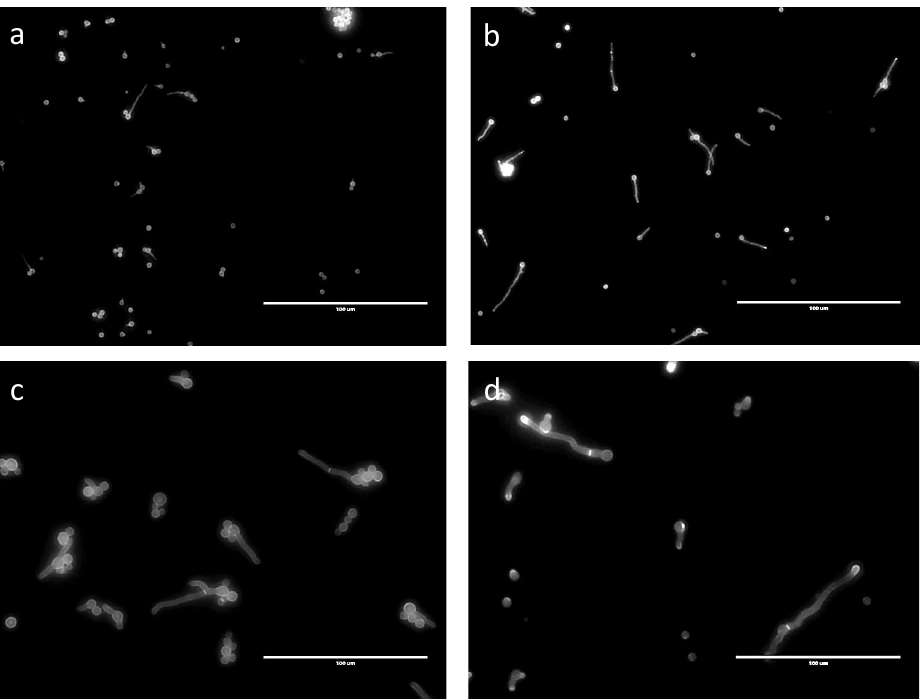
Figure 7. Septa shown by CalcoFluor staining of germinating conidia in different media. ( a ) G; ( b ) GA; ( c ) GAP; ( d ) MM.